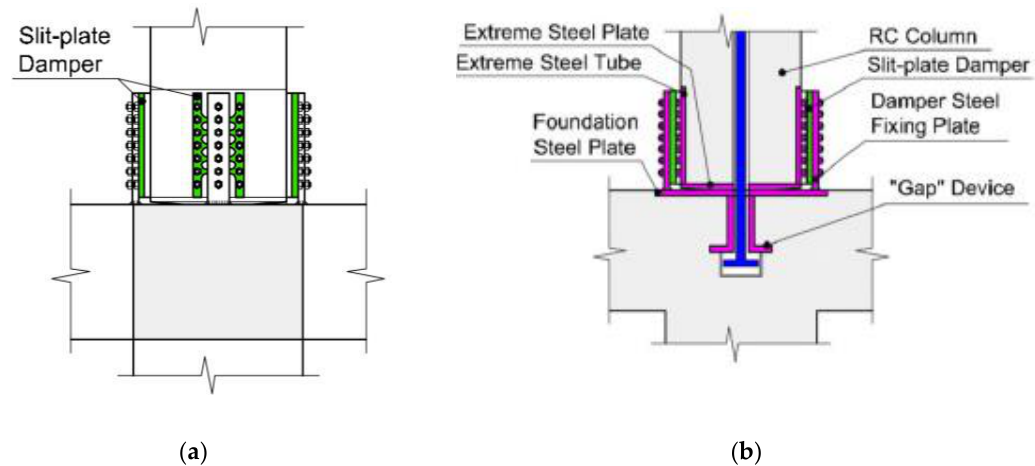
Figure 4. Installation of the slit-plate damper at the ends of the rocking columns: ( a ) Elevation; ( b ) section through the plane of the frame.